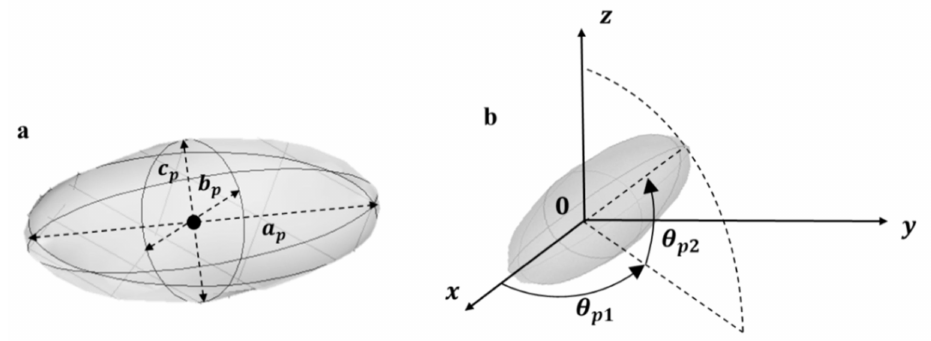
Figure 1. Modelling a particle as a spheroid in 3D space. ( a ) a p : major axis, b p : minor axis, c p : third axis ( b ) θ p 1 : Azimuth angle. θ p 2 : elevation